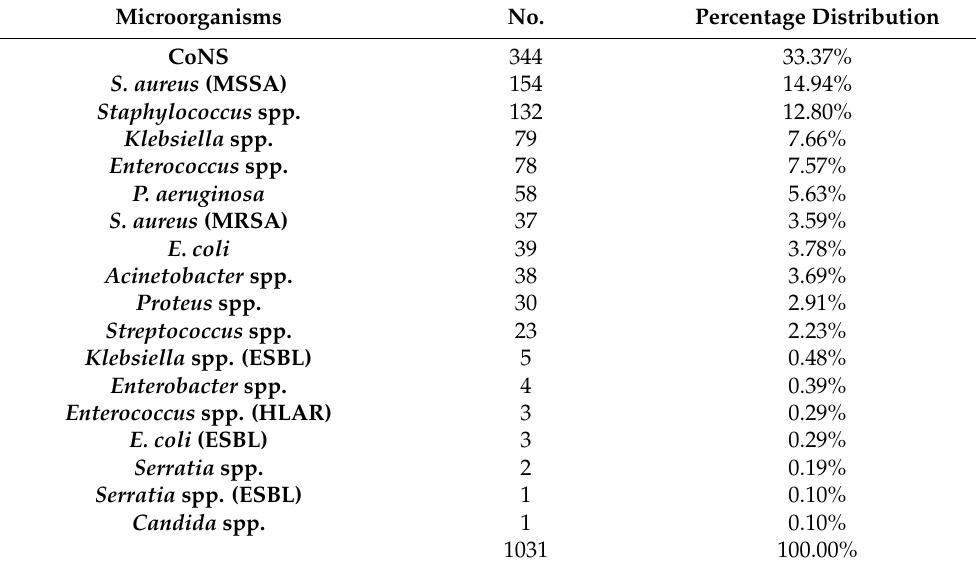
Table 5. Distribution of isolated microorganisms at the time of hospital admission.